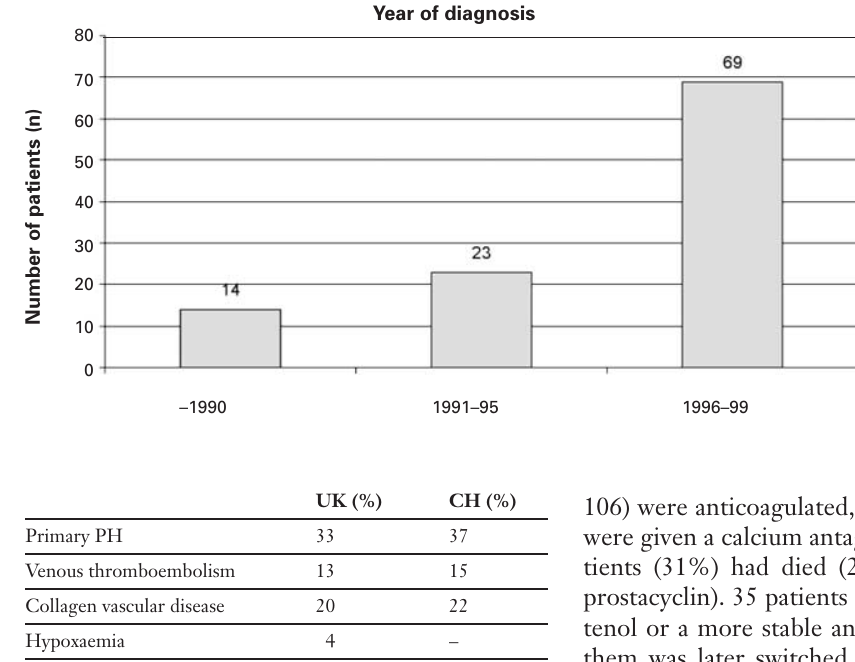
Aetiological distribu- tion in patients with pulmonary hyperten- sion (PH). Compari- son between data of United Kingdom (UK) and Switzerland (CH).